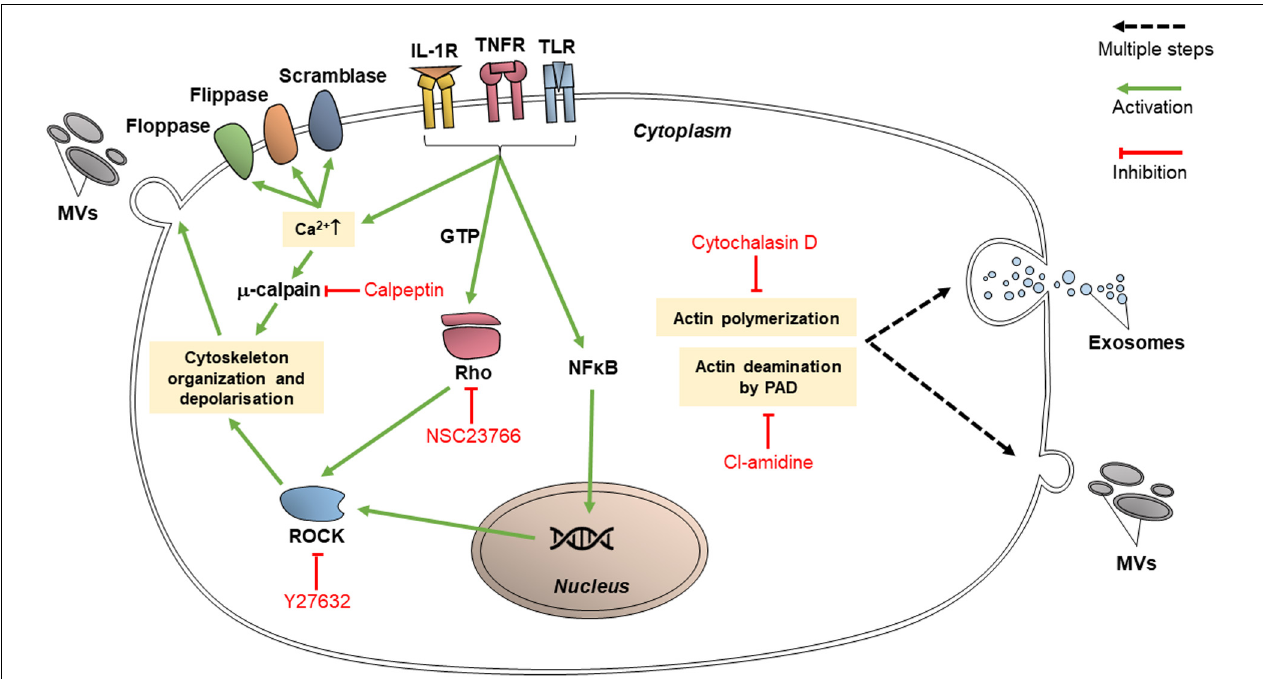
FIGURE 3 | Inhibitors of cytoskeletal organization pathways (calpeptin, Y27632, NSC23766, cytochalasin D, and chloramidine/Cl-amidine) inhibit EV release through intracellular trafficking and budding of the vesicles.